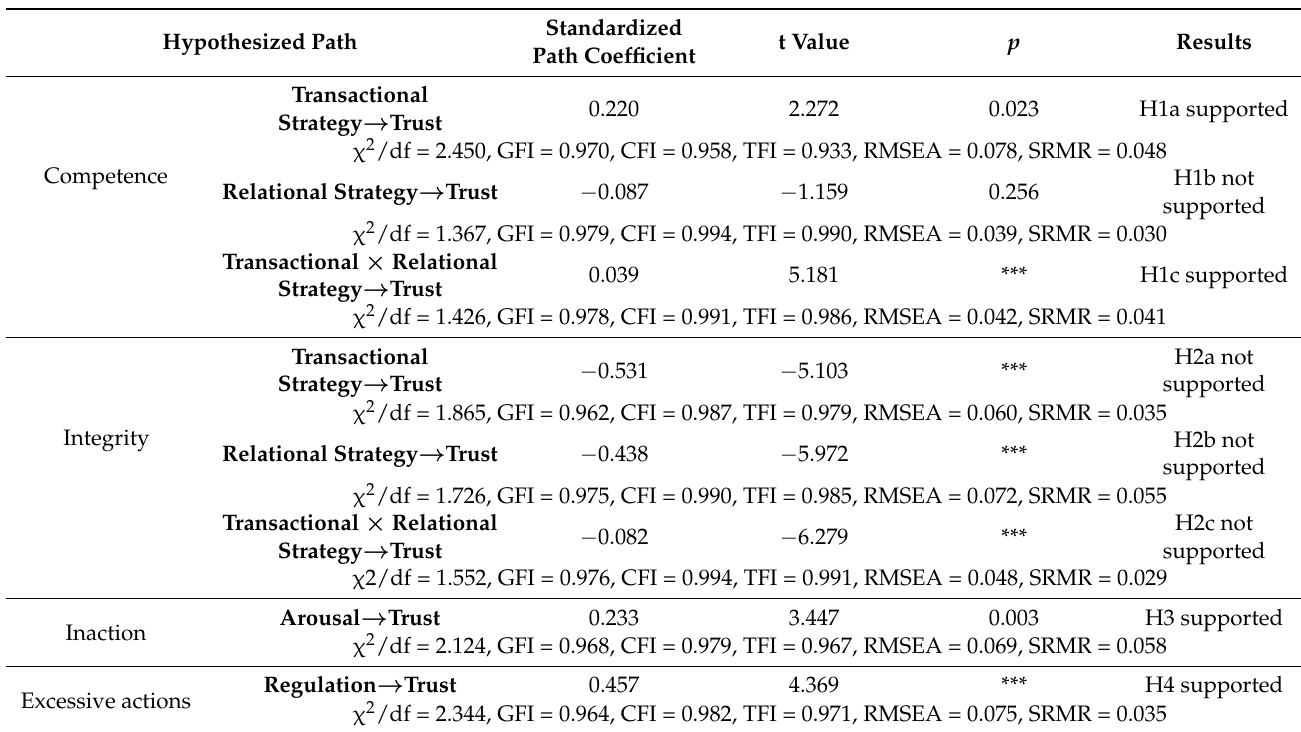
Table 4. Results of regression